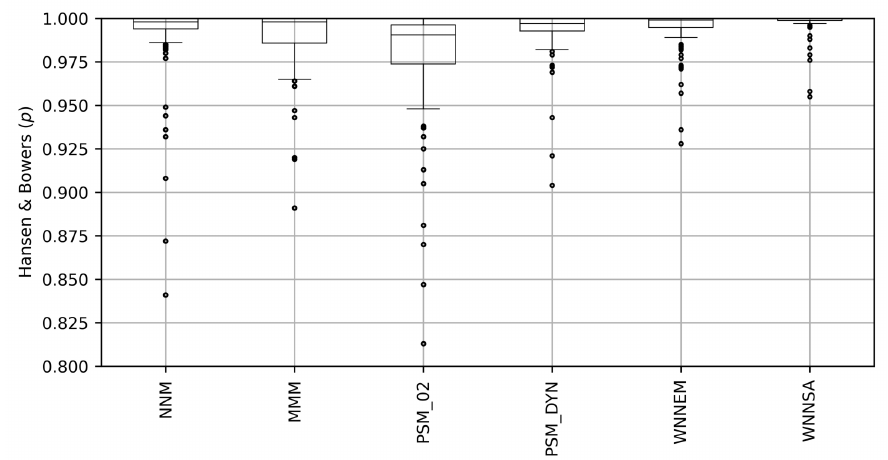
Figure 3. Results of the Hansen and Bowers test in Scenario I. Comparison of the p -values of the Hansen and Bowers test in case of the nearest neighbour matching (NNM), Mahalanobis metric matching (MMM), two types of PSM methods (PSM_02, PSM_DYN), the WNNEM method and the WNNSA method for the 100 datasets in Scenario